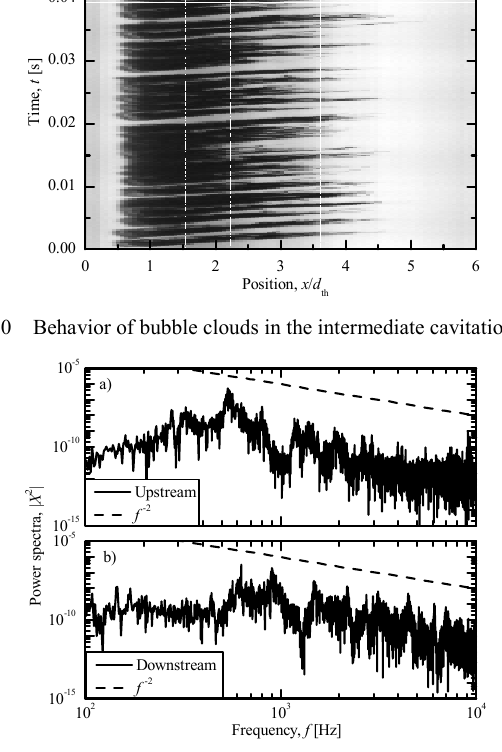
Fig. 11 Power spectra of the pressure fluctuation upstream and downstream of the nozzle in the intermediate cavitation